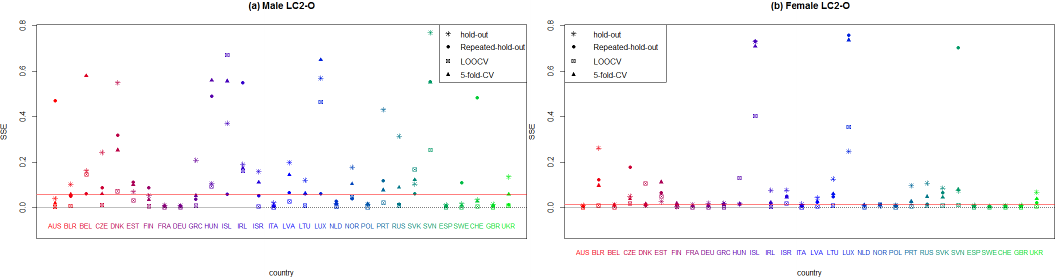
Figure A5. Plot summarizing the sum of squares errors (SSE) of each European country that applies bifactorial Lee–Carter model with orthogonalized parameters to males and females, according to every employed resampling